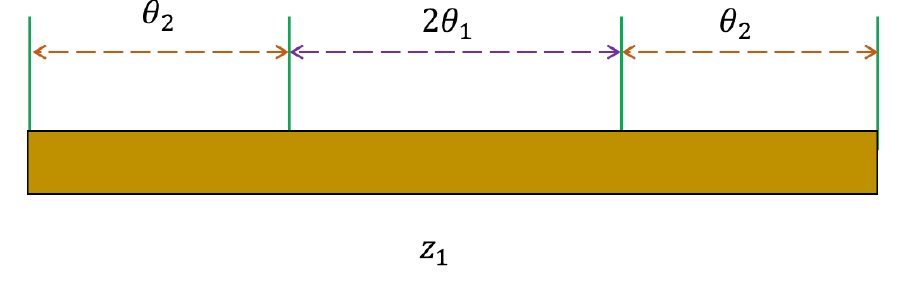
Figure 3. Half-wavelength UIR.